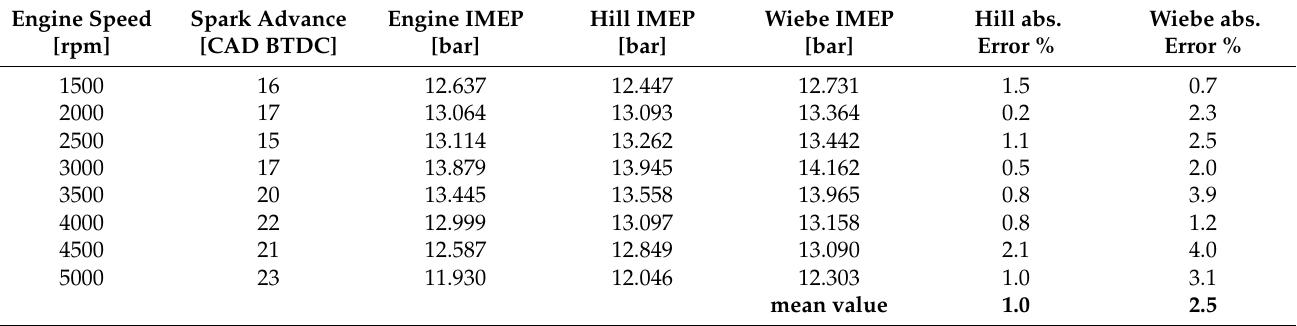
Table 6. Experimental and simulated IMEP with absolute prediction errors (40% NG; MAP = 1.4 bar).